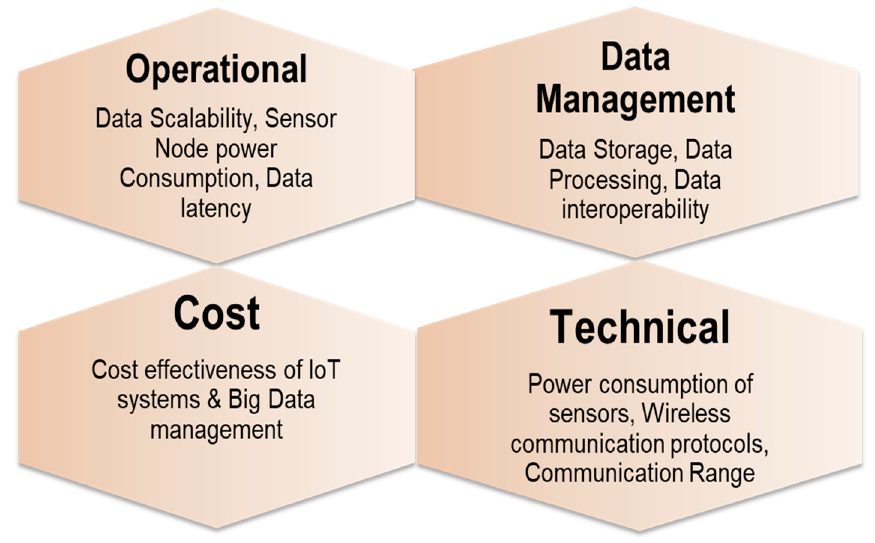
Figure 1. Cost, Technical, Operational and Data management barriers. Source: “Reprinted/adapted with permission from Ref. [4]. 2019, Junhu Ruan”.